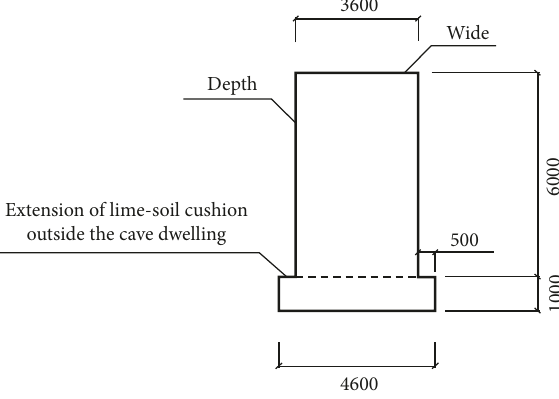
Figure 4: The schematic diagram of the range of lime-soil damp- proof